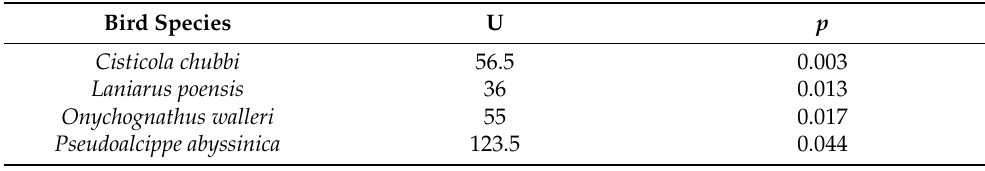
Table 5. Comparison of abundances of the most common species between forest and pasture points ( n = 44). Mann Whitney U tests.